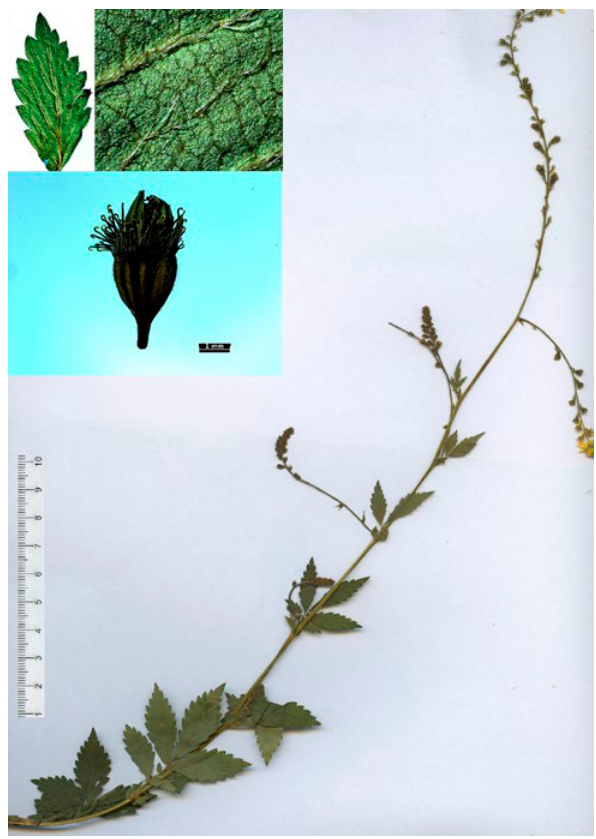
Figure 1. Agrimonia pilosa Ledebour (Beijing,